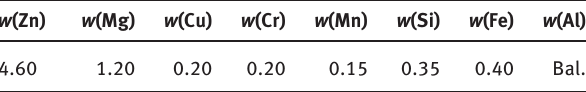
Table 1: Chemical composition (wt.%) of a 7N01-T4 aluminum alloy plate.